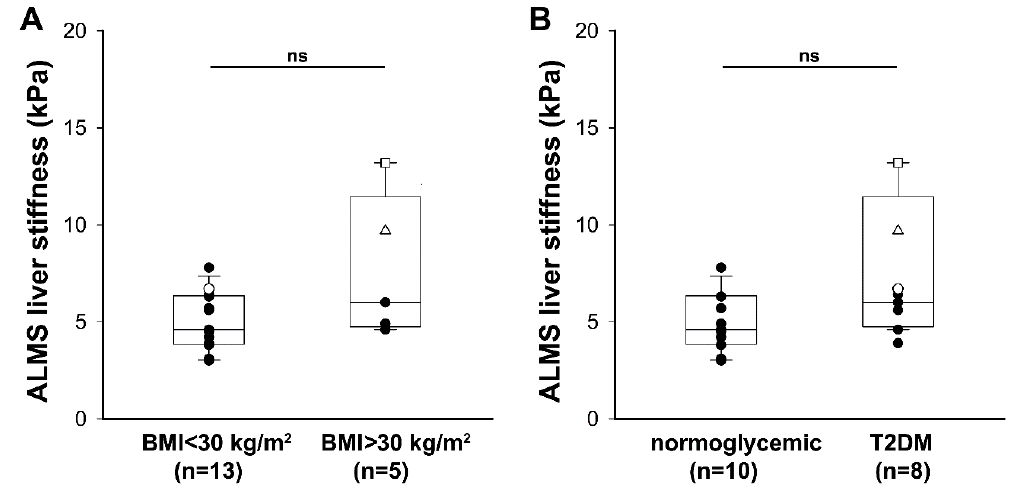
Figure 4. Liver stiffness and metabolic complications in patients with ALMS: ( A ) liver stiffness evaluated by shear wave elastography in patients with ALMS divided into subgroups according to the presence of obesity; ( B ) liver stiffness evaluated by shear wave elastography in patients with ALMS divided into subgroups according to the presence of type 2 diabetes mellitus (T2DM) . Data are reported as a box plot with 25th and 75th percentiles and median values. ID 1 (white triangle), ID 2 (white circle), and ID 5 (white square) patients had clinical signs of portal hypertension and are described in detail in Table 3. Statistical analysis was performed using the Mann–Whitney